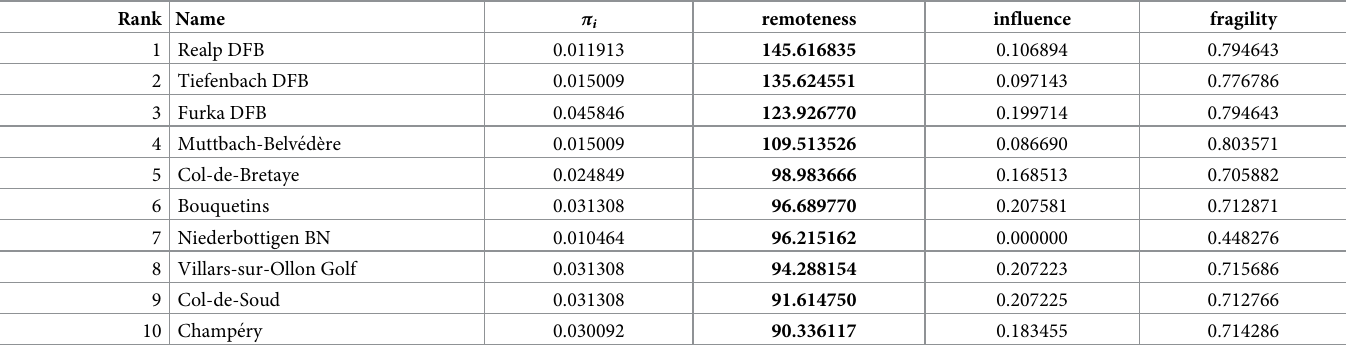
Table 1. Top ten most remote stations, 1 month median.